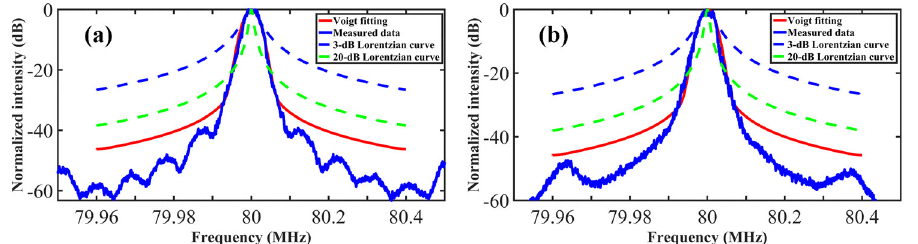
Figure 8. The self-heterodyne spectrum of BEFL and Voigt fitting curves. ( a ) 20 km and ( b ) 50 km delay fiber.